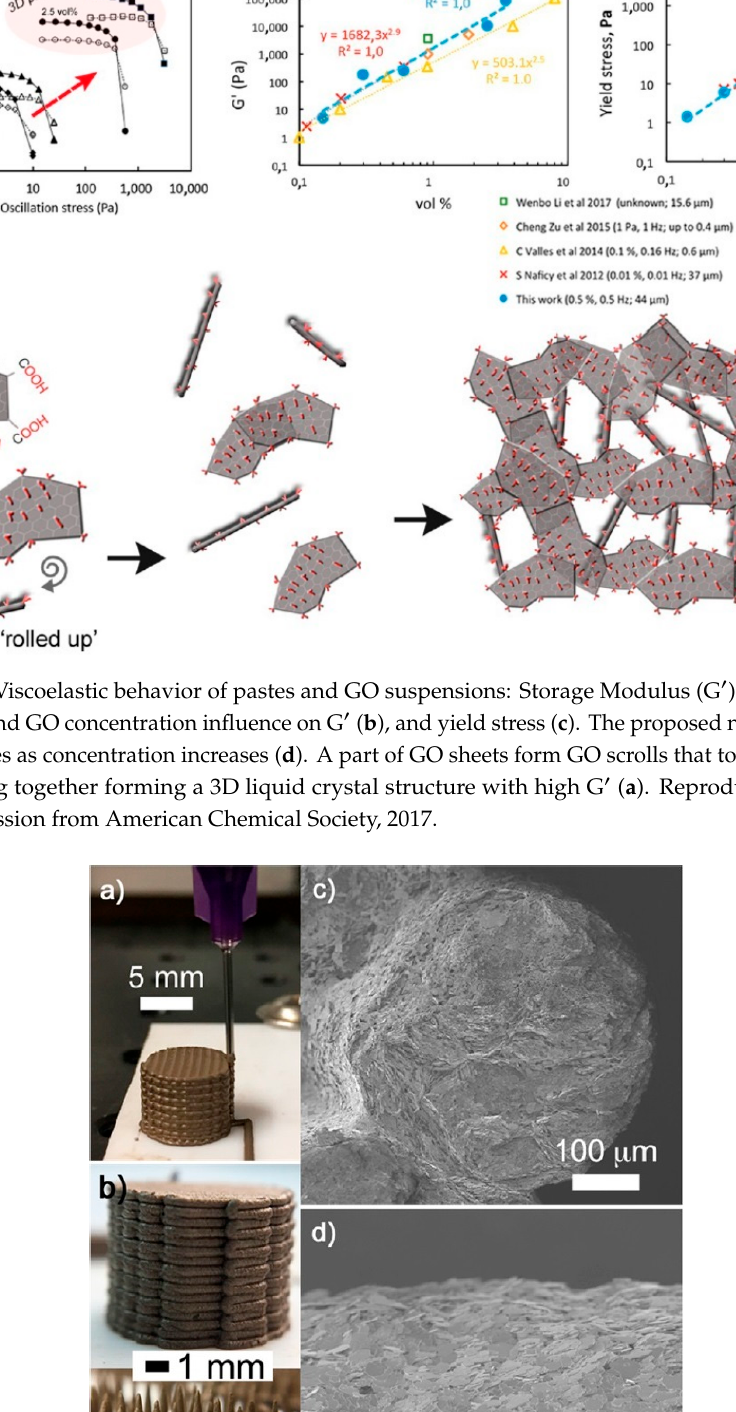
Figure 26. Cylinder printed by DIW from GO/Al 2 O 3 platelets paste and sintered at 1550 °C. ( a − c ). The SEM images show the cylinder microstructure with open porosity of 60% determined by Archimedes’ Principle ( d ) and ( e ). Reproduced from [29], with permission from American Chemical Society, 2017. The SiC paste also showed suitable printing behavior. Dried 3D printed bars had strengths of ~1 MPa which demonstrates that in this case the GO also operates as a binding agent between the SiC particles. Bars printed from GO/SiC paste and sintered at 2050 °C for 2 h showed a density of 3.21 g/cm 3 and reached a bending strength of around 212 MPa. In both cases, Al 2 O 3 and SiC were the unique crystalline phase in the sintered objects, and Raman spectroscopy demonstrated that no carbon residues remained in the structure. Note that, it is possible